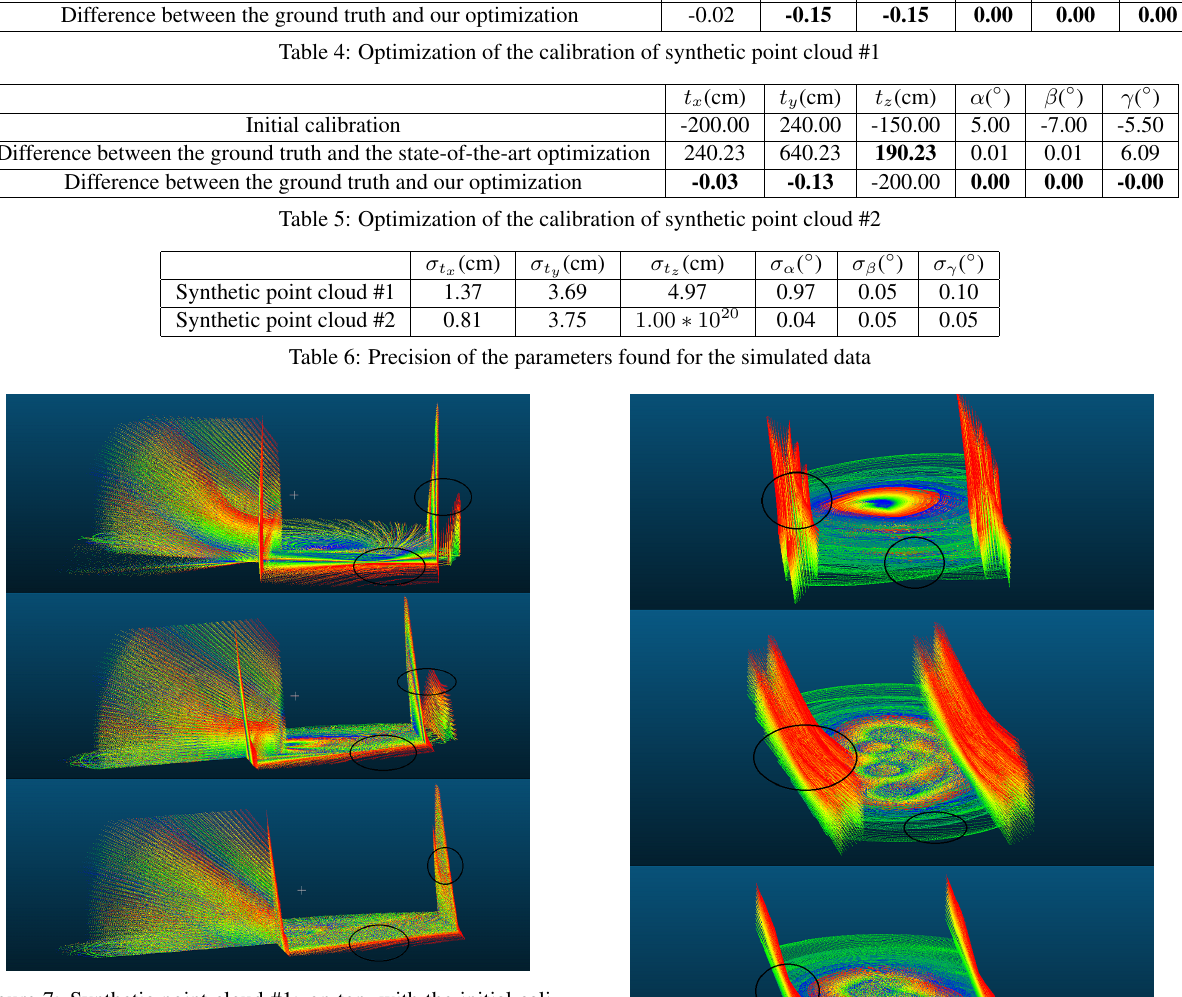
Figure 7: Synthetic point cloud #1: on top, with the initial cali- bration; middle, with a state of the art optimization; at the bottom, with our optimization. The three images have the same point of view.